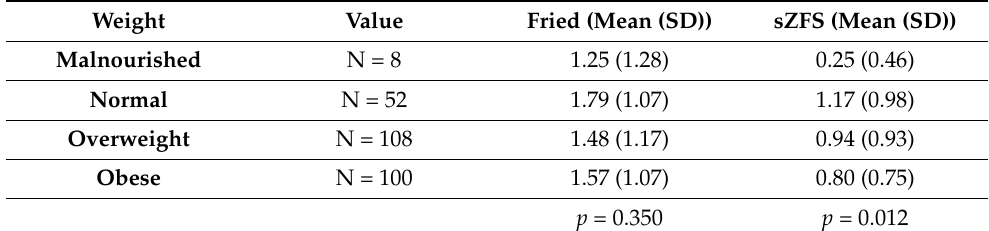
Table 3. Study correlation between obesity and frailty